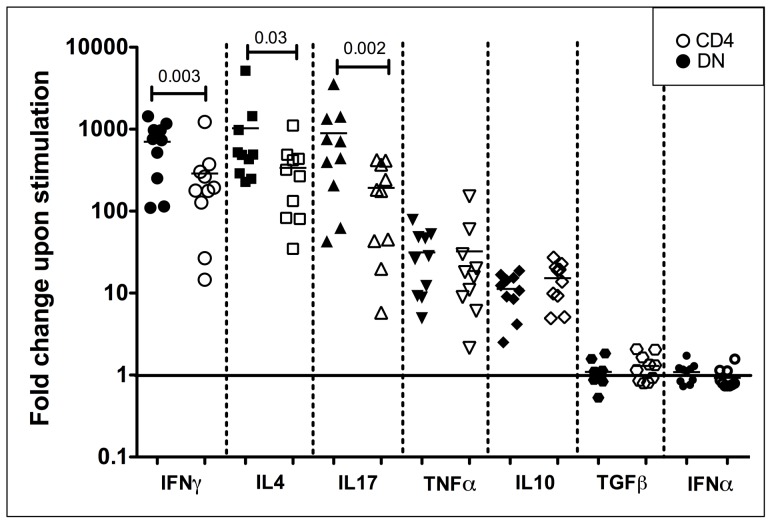
Quantitative real time PCR analysis of TCR stimulated DN and CD4 T cells from uninfected mangabeys.Purified DN (filled symbols) and CD4 (open symbols) T cells isolated from ten uninfected magabeys were stimulated with anti-CD3/anti-CD28. Upon stimulation, DN T cells upregulate IFNγ, IL4 and IL17 mRNA to the greatest extent with higher expression of these genes (paired analysis) in DN compared to CD4 T cells. TNFα and IL10 mRNA were also upregulated by both DN and CD4 T cells. TGFβ and IFNα expression was not altered following TCR stimulation in either DN or CD4 T cells. Log scale fold change is shown on the Y-axis with no change in mRNA expression due to stimulation indicated by a baseline (1 fold). Symbols represent IFNγ (large circle), IL4 (square), IL17 (triangle), TNFα (inverted triangle), IL10 (diamond), TGFβ (hexagon) and IFNα (small circle).